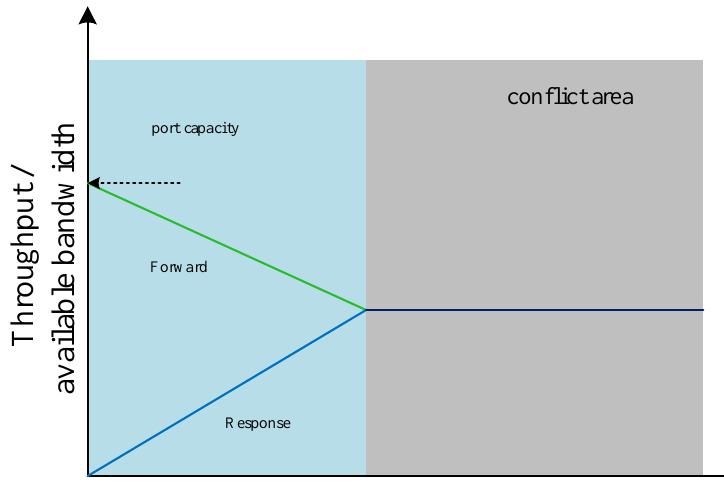
Figure 2. Bandwidth competition.